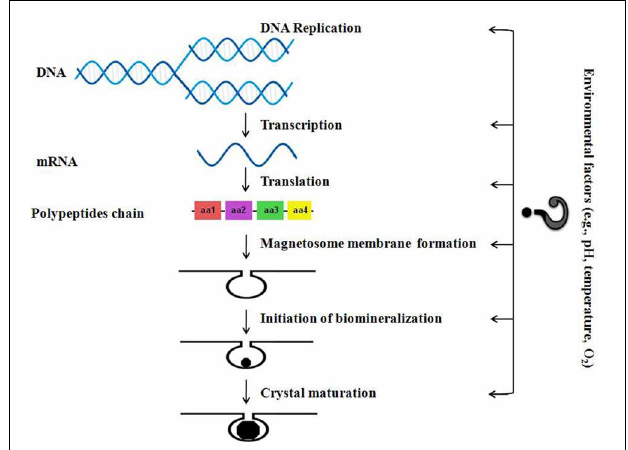
FIGURE 2 | Schematic diagram about how different environmental factors could possibly affect magnetosome synthesis in MTB (adapted after Murat et al.,